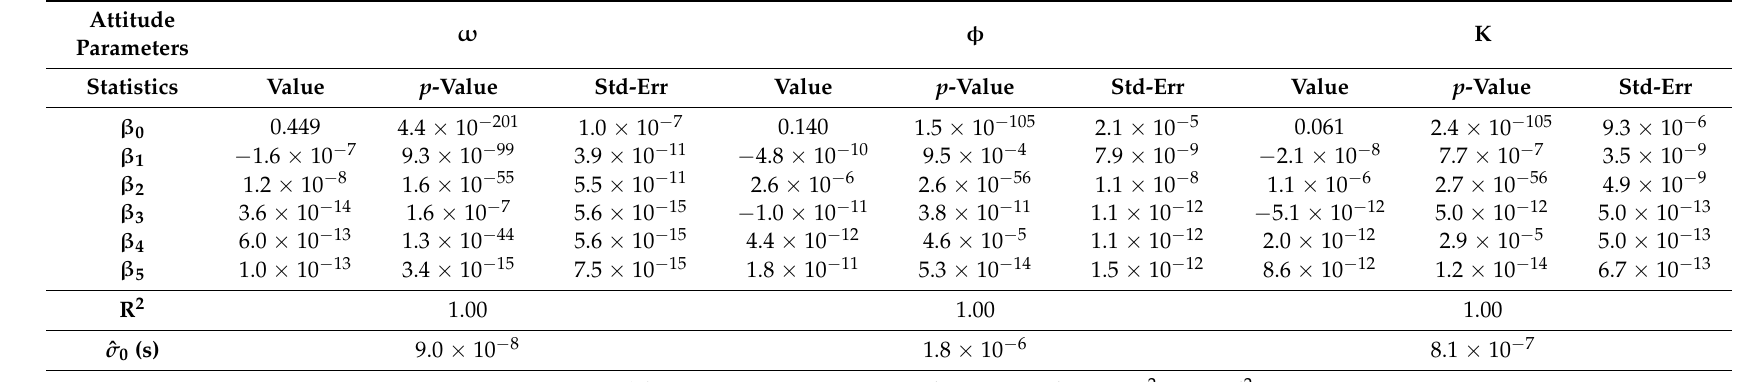
Table 1. Statistics of the polynomials fitted to the attitude parameters of the IB of